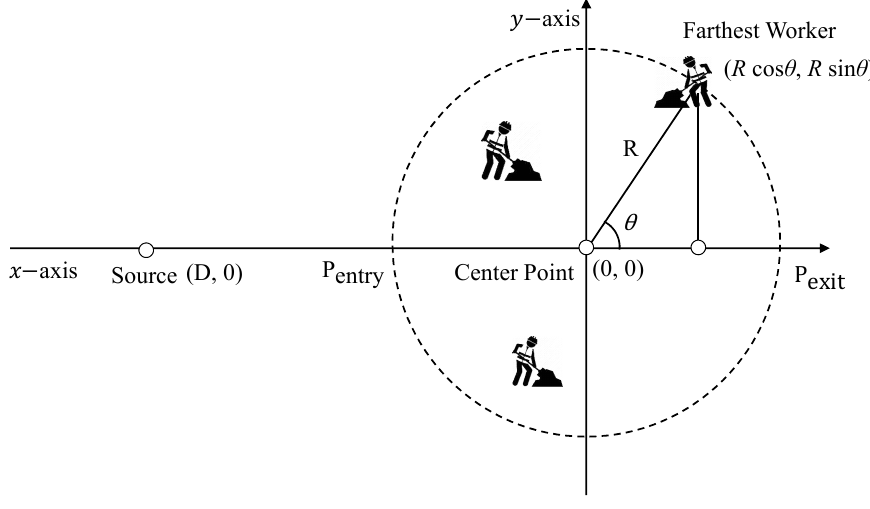
Figure 5. Calculation of longest distance in the